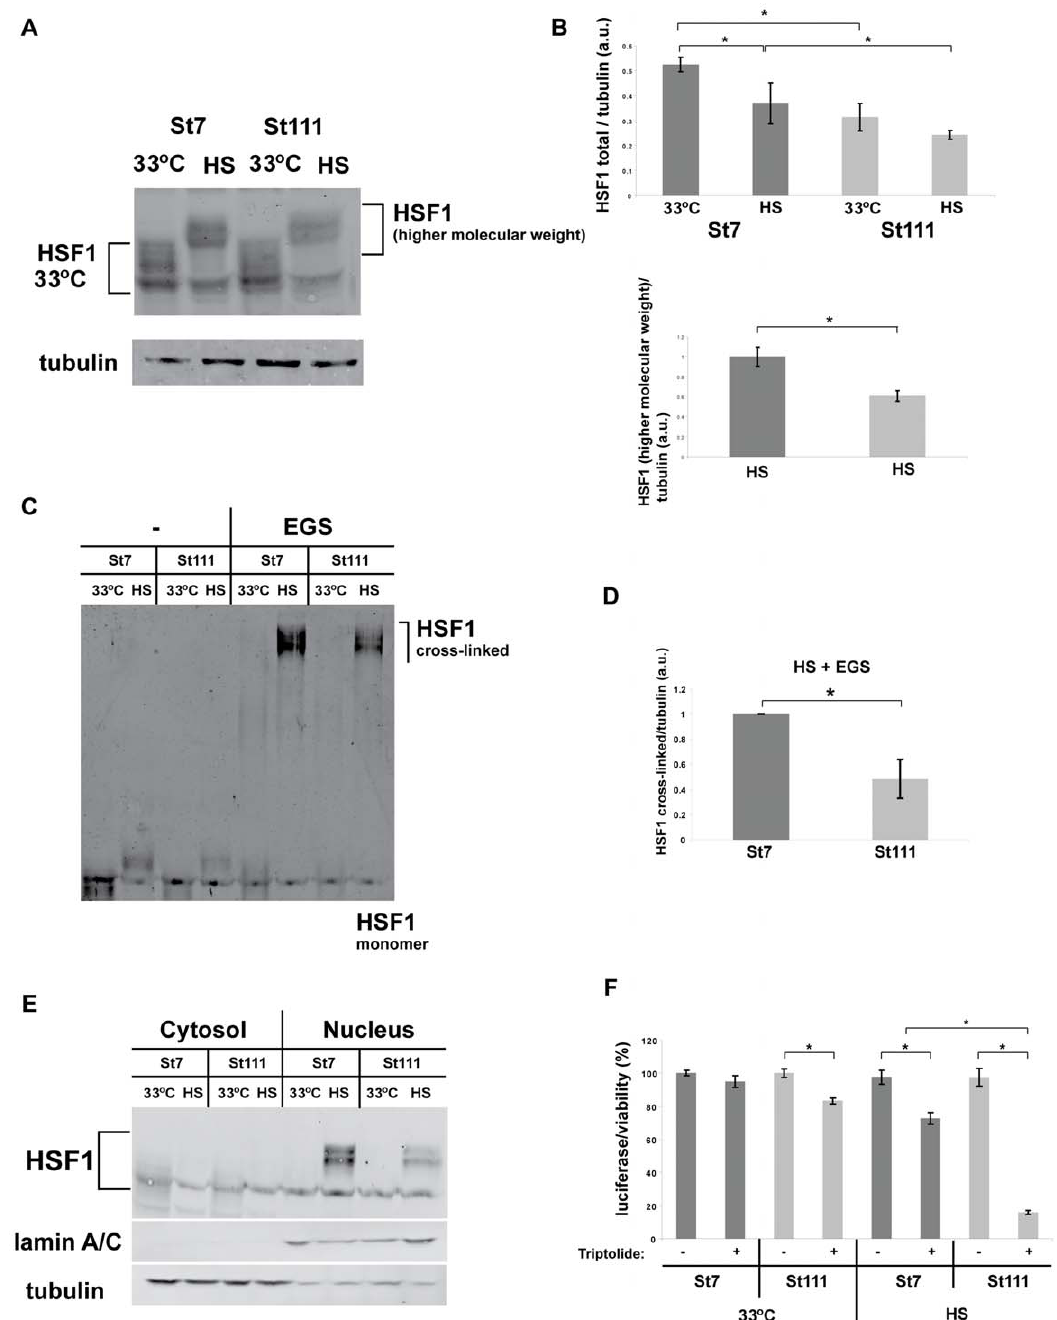
Figure 5. Reduced HSF1 levels in cells expressing polyQ-expanded Htt. A ) Western blots prepared with protein lysates from STHdh(Q7) and STHdh(Q111) cells that were grown at 33 u C or heat shocked (HS, 42 u C for three hours). The blots were probed with anti-HSF1 antibodies and